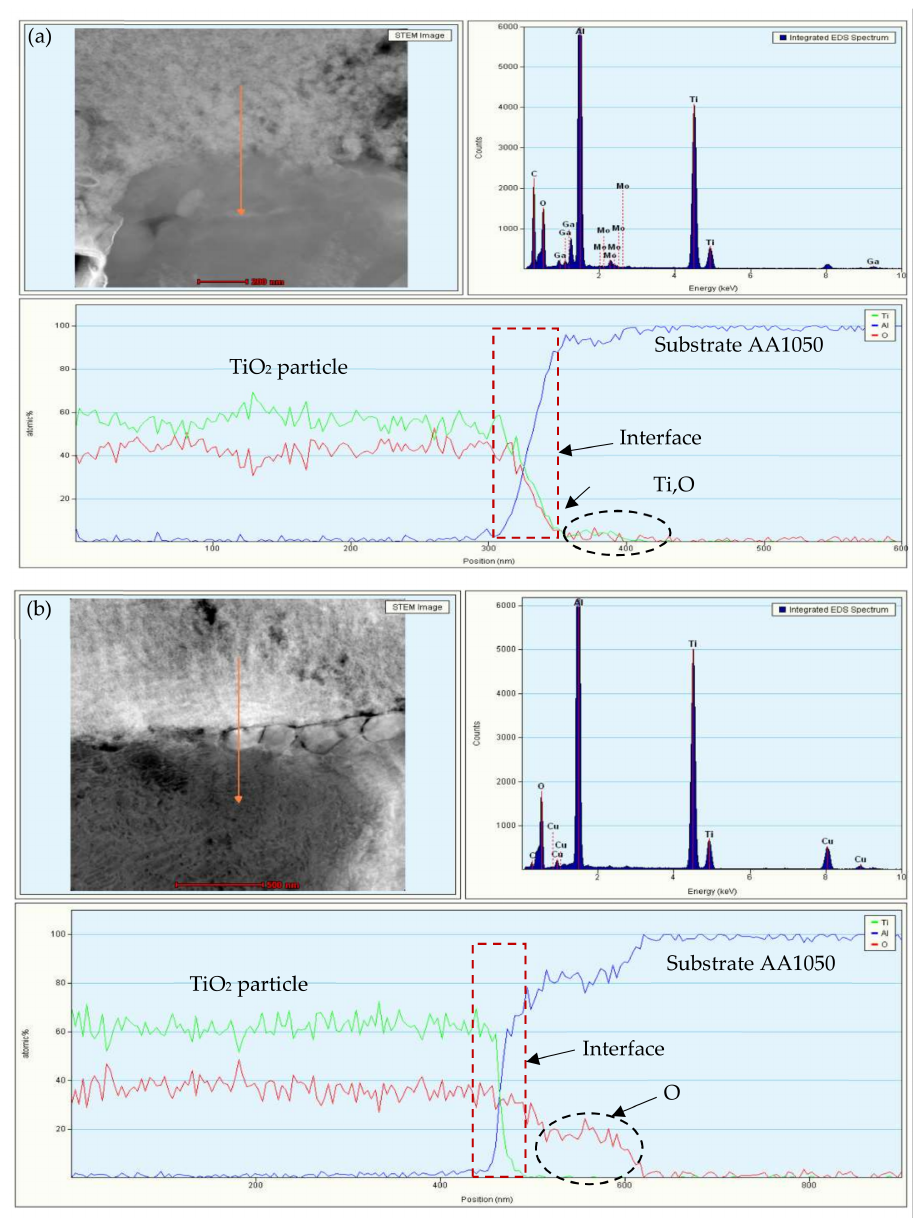
Figure 14. TEM line analysis of the TiO 2 particle on AA1050 ( a ) at RT ( b ) annealed at 400 ◦